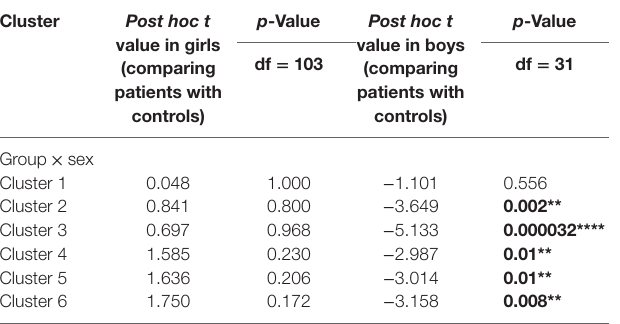
TaBle 4 | Post hoc tests of the percent signal changes from the regions showing significant group × sex interactions. cluster Post hoc t value in